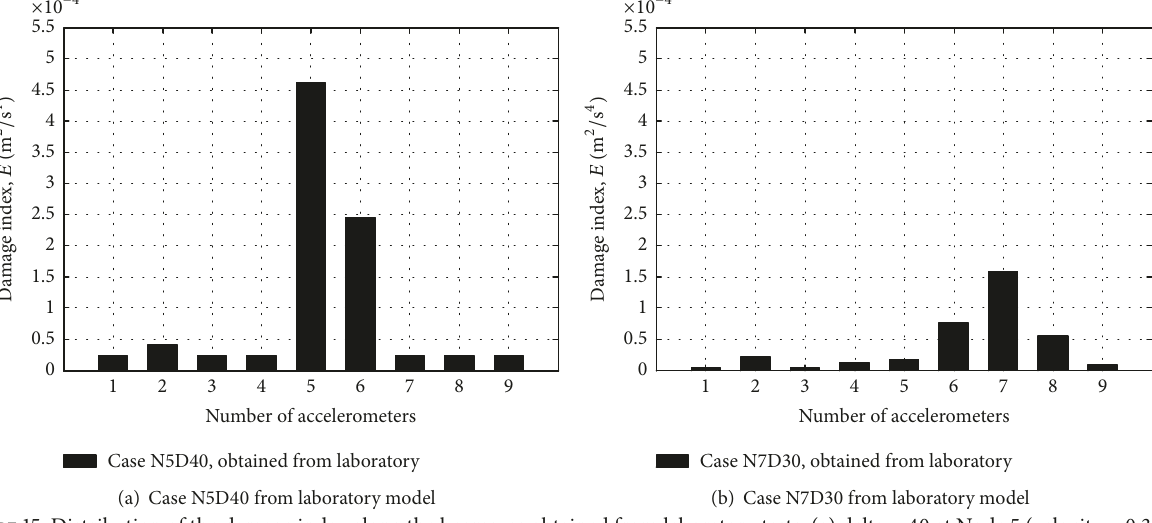
Figure 15: Distribution of the damage index along the beams, as obtained from laboratory tests: (a) delta = 40 at Node 5 (velocity = 0.3 m/s) and (b) delta = 30 at Node 7 (velocity = 0.3 m/s).